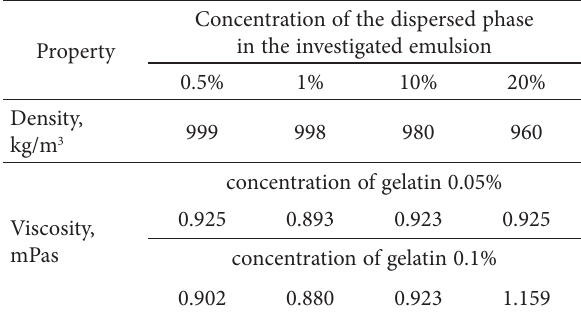
Table 1. Properties of the prepared “oil-in-water” emulsions